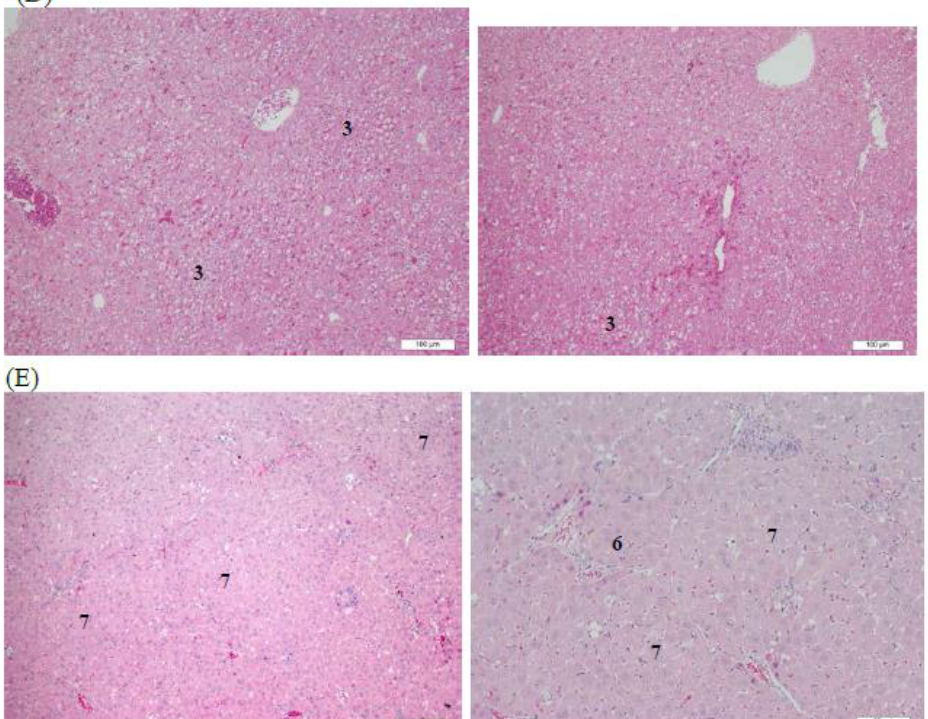
Figure 5. Histopathological analysis of retrorsine-CCl 4 -induced rat liver fibrosis and necrosis in the presence or absence of injective treatments. ( A ) Severe liver fibrosis ( 1 ) and necrosis/degeneration of hepatocytes ( 2 ) were observed before the treatments injected; ( B ) Obvious liver fibrosis ( 1 ) and necrosis/degeneration of hepatocytes ( 2 ) as well as numerous fatty degeneration-like areas ( 3 ) were seen without treatment after 2-week (negative control); ( C ) Liver fibrosis/necrosis was clearly decreased in most areas compared to negative control while in a few areas the fibrotic tissues ( 4 ), inflammatory cell infiltration ( 5 ) and some formation of pseudolobules ( 6 ) were seen after 2 week treatment with HAn injection; ( D ) Liver fibrosis and necrosis were not observed as some fatty degeneration-like areas ( 3 ) were found after AHAna injection for 2 weeks; ( E ) Liver fibrosis and necrosis were reduced whereas swelling of hepatocyte ( 7 ) and formation of pseudolobules ( 6 ) were observed after 2 week injection of pure Asta.